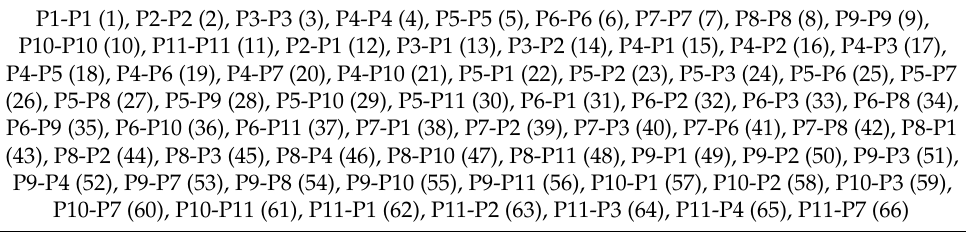
Table 3. Numbering and symbols denoting responses of the Rotman